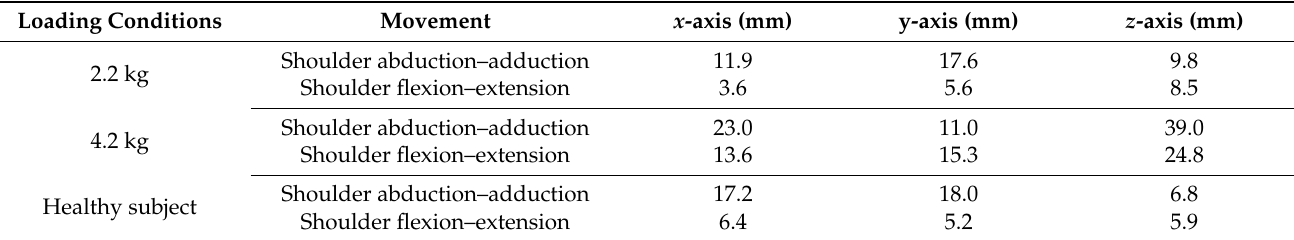
Figure 9. Movement of shoulder abduction–adduction—2.2 kg load ( a ) on the x -axis, ( b ) on the y -axis, and ( c ) on the z -axis. Table 6. Absolute error in trajectories under loading conditions.